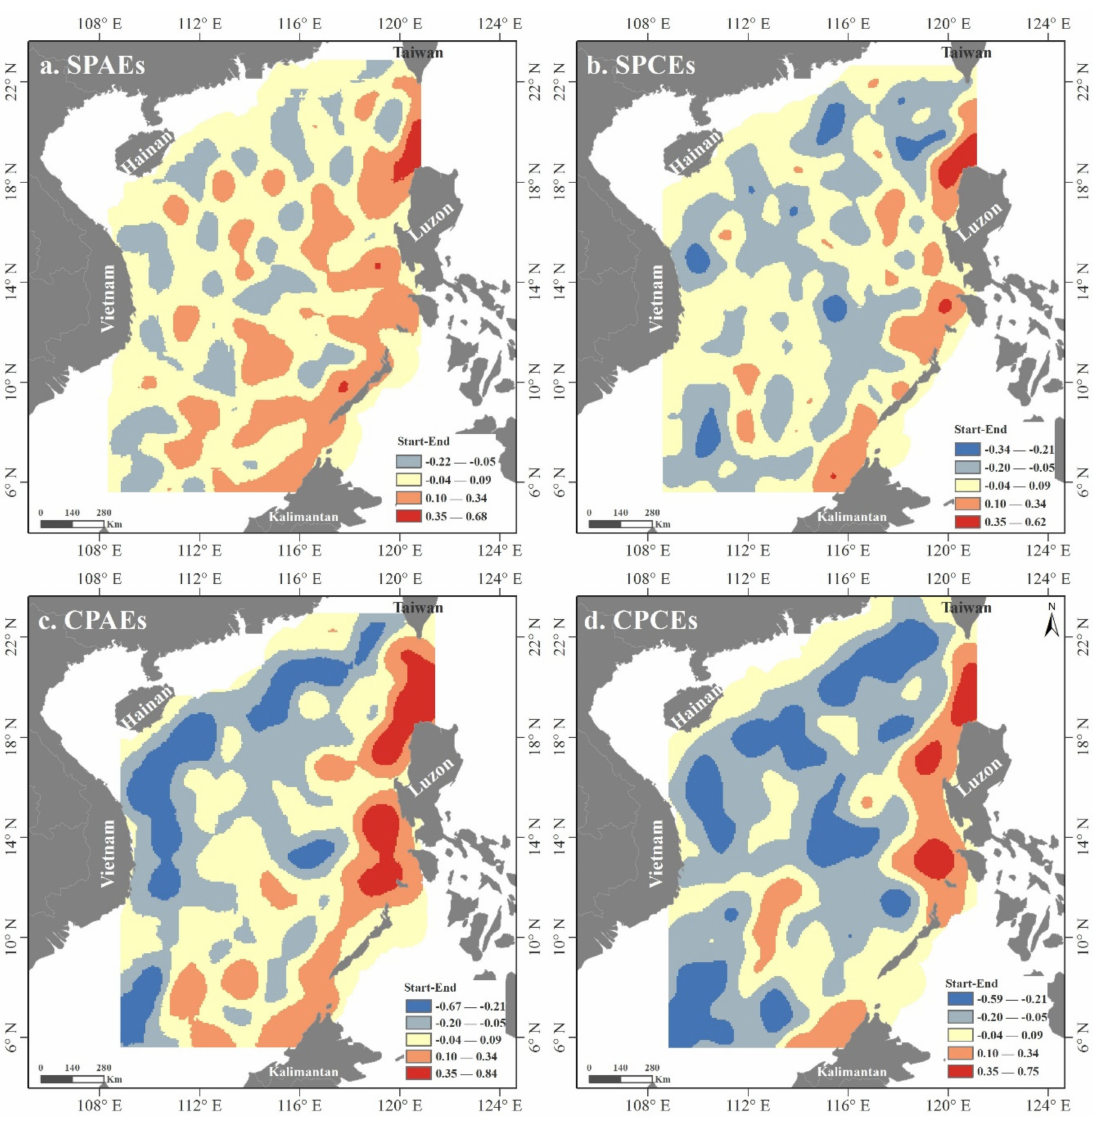
Figure 4. The di ff erence of the kernel density of the starting and ending points of simple processes of anticyclonic eddies (SPAEs) ( a ), simple processes of cyclonic eddies (SPCEs) ( b ), complex processes of anticyclonic eddies (CPAEs) ( c ), and complex processes of cyclonic eddies CPCEs ( d